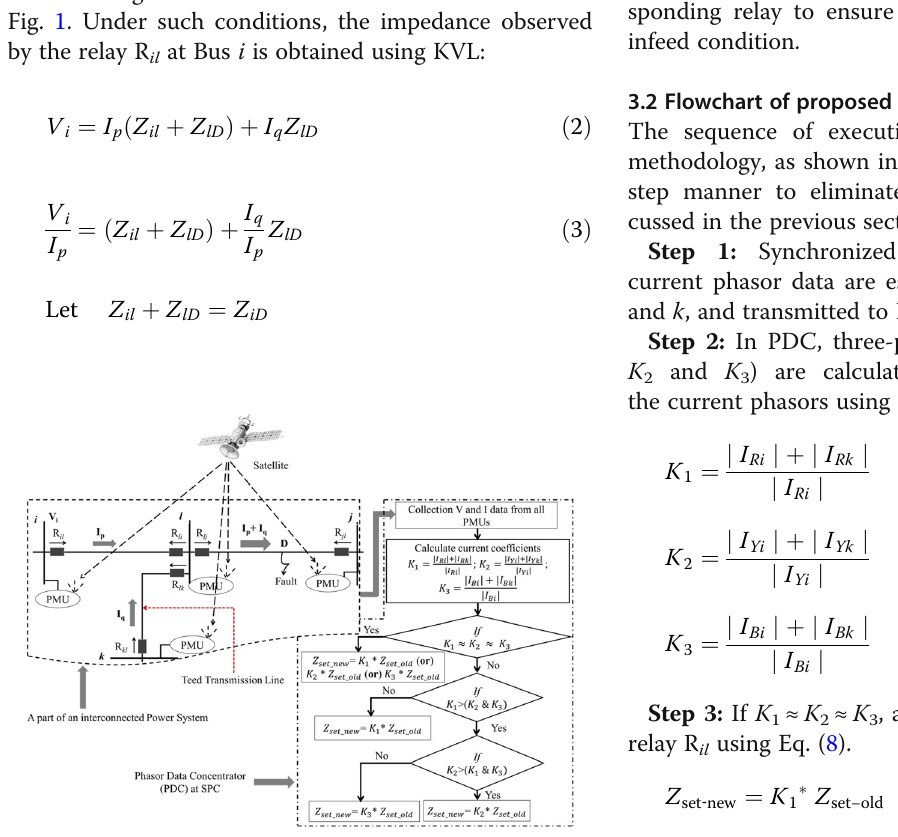
Fig. 1 Proposed PAZSD methodology for multi-terminal transmission lines